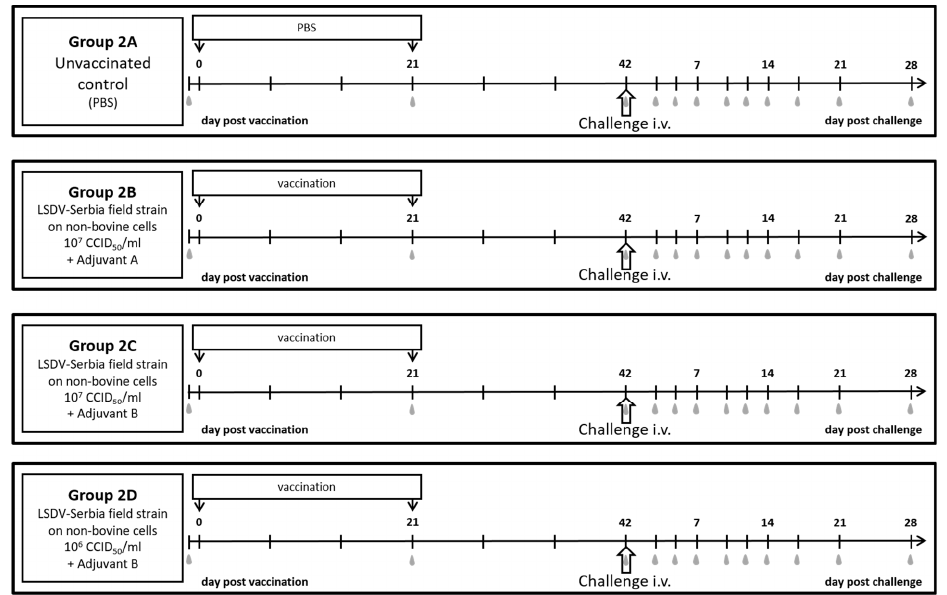
Figure 2. Experimental design of the performed vaccine-efficacy study. Cattle of Group 2A were not vaccinated but received PBS instead. The cattle of the other groups were vaccinated with inactivated LSDV-“Serbia“ field strain propagated on a non-bovine cell line. Group 2B received a vaccine with a virus infectious titer before inactivation of 10 7 CCID 50 /mL and Adjuvant A. For Group 2C and 2D, the inactivated virus was used with different titers (10 7 CCID 50 /mL and 10 6 CCID 50 /mL, respectively) and Adjuvant B. Grey marks display sampling